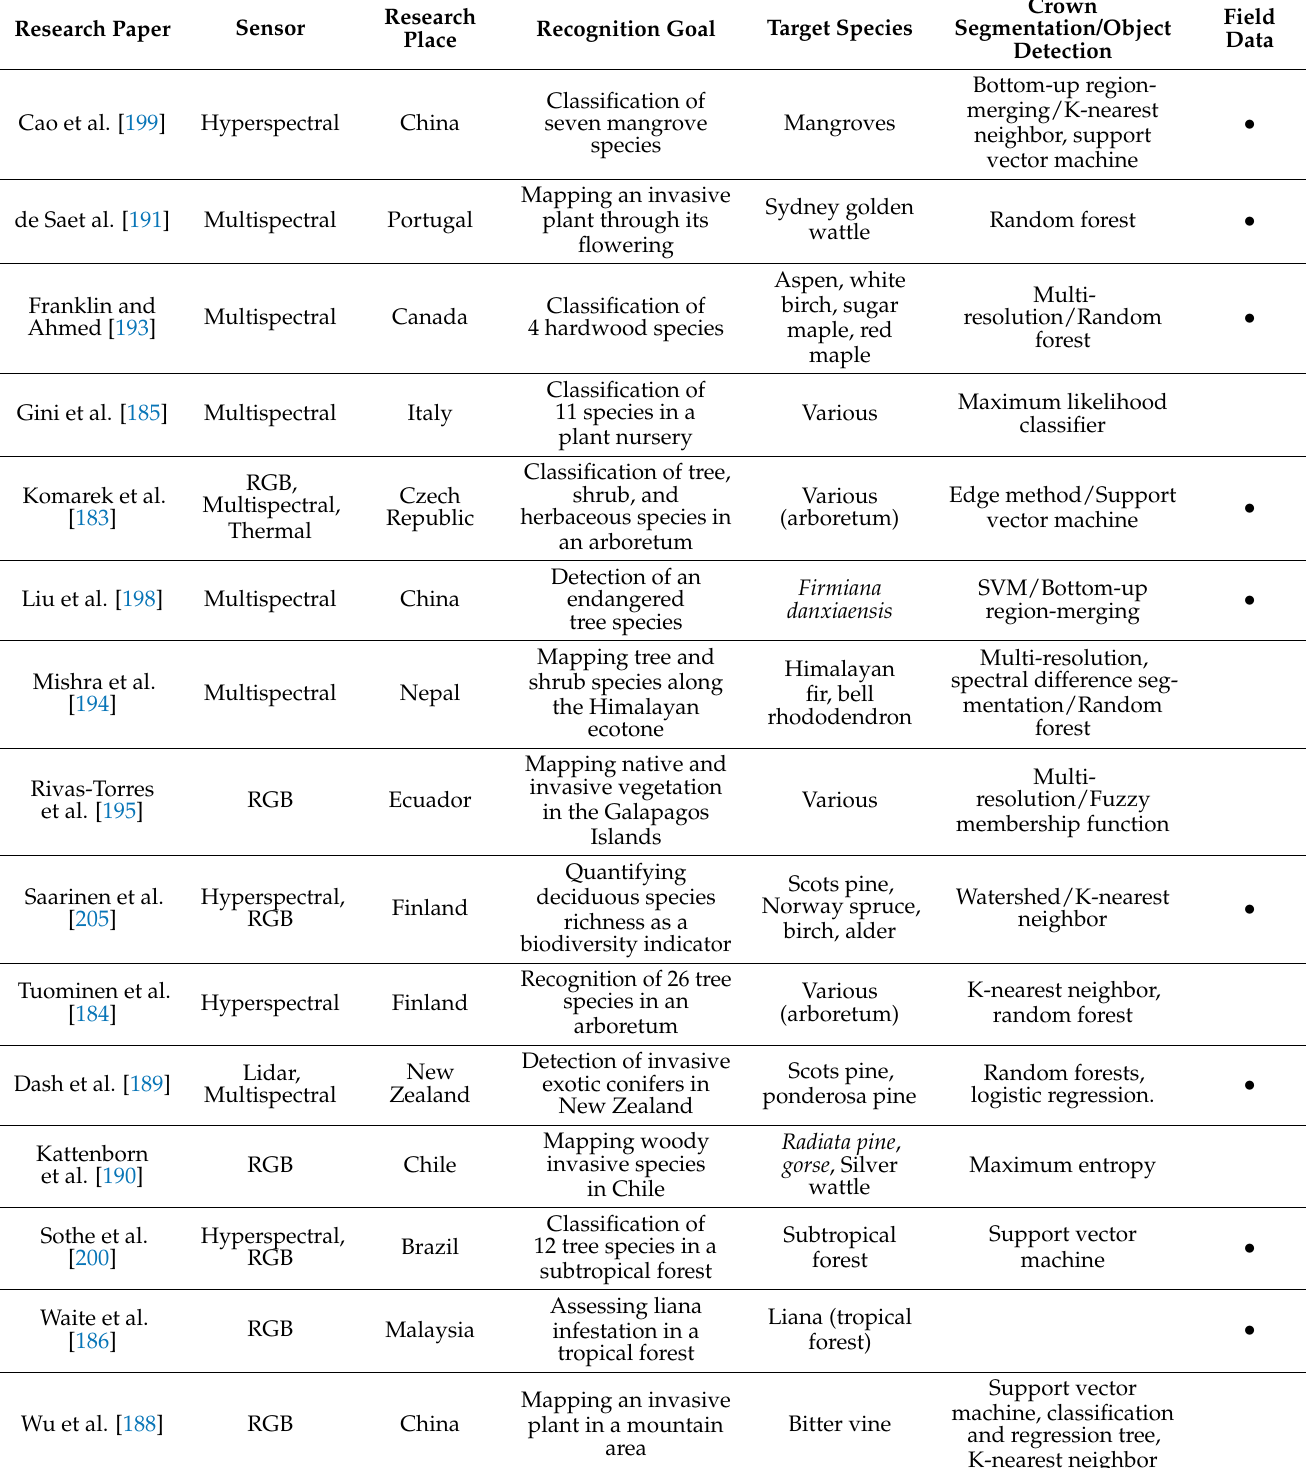
Table 5. Reviewed studies for species recognition and invasive plant detection topic: sensor, research place, recognition goal, target species, crown segmentation algorithm/object detection method, and field data